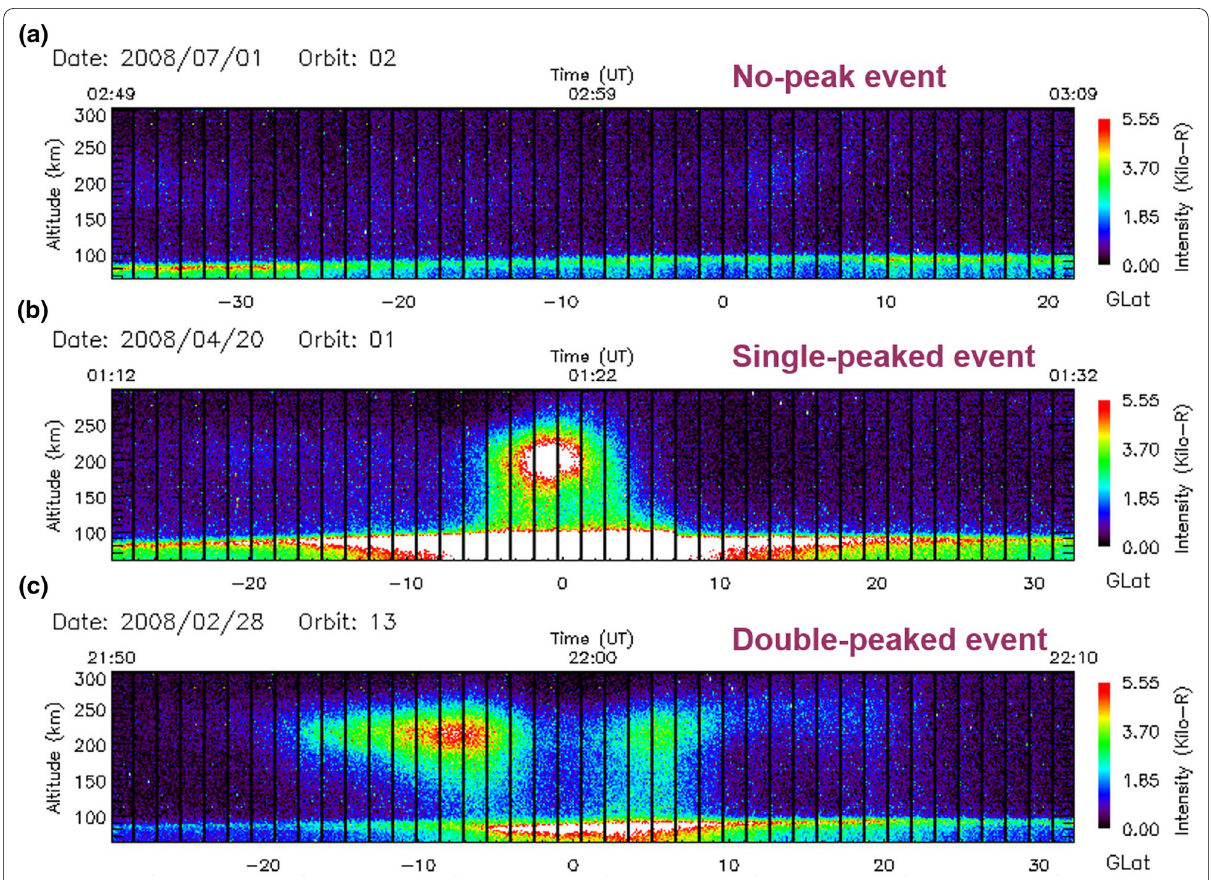
Fig. 2 Three types of equatorial brightness events around midnight observed by ISUAL: a a no‑peak event; b a single‑peaked event; c a double‑peaked event